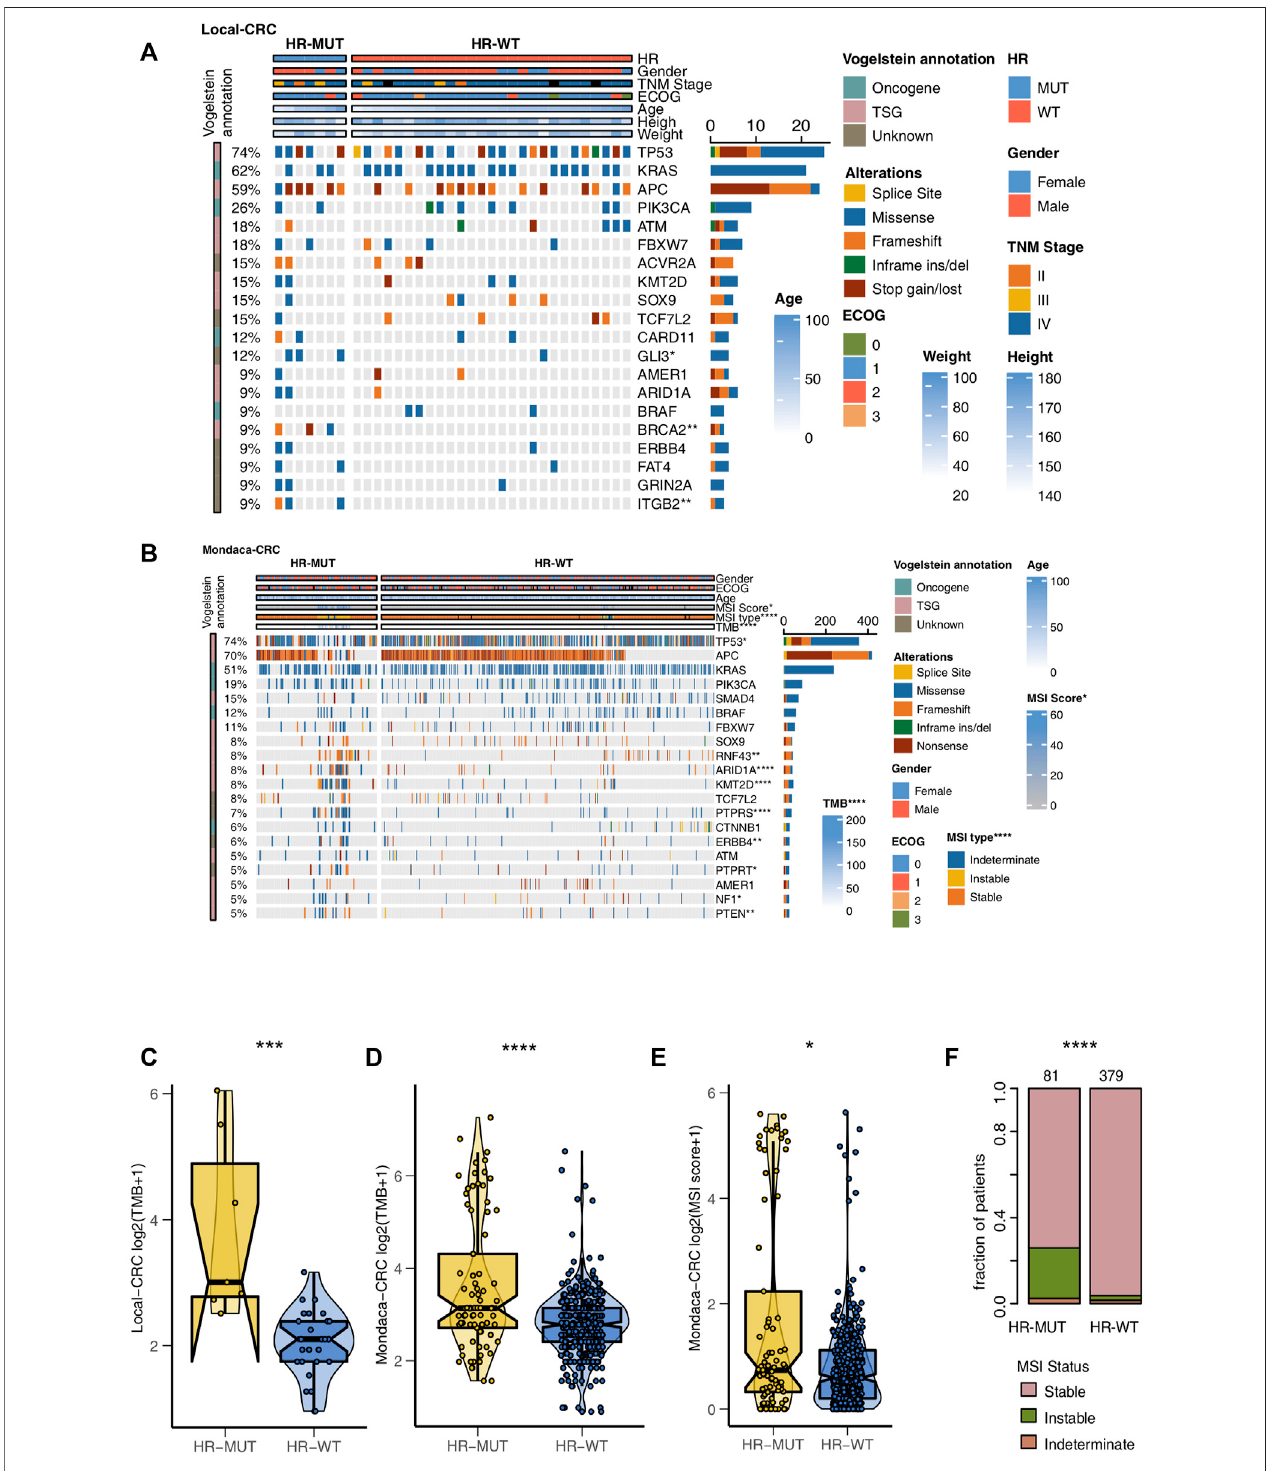
FIGURE4| Themutationpro fi lesoftheHR-MUTandHR-WTCRCpatients.ThemutationallandscapeofthetopmutatedgenemutationsintheLocal-CRCcohort (A) andMondaca-CRCcohort (B) .AcomparisonoftheTMBlevelsoftheHR-MUTgroupandHR-WTgroupintheLocal-CRCcohort (C) andMondaca-CRCcohort (D) . AcomparisonbetweentheMSIscores (E) andMSIstatuses (F) theHR-MUTandHR-WTgroupsintheMondaca-CRCcohort(* p < 0.05;** p < 0.01;*** p < 0.001;**** p < 0.0001).